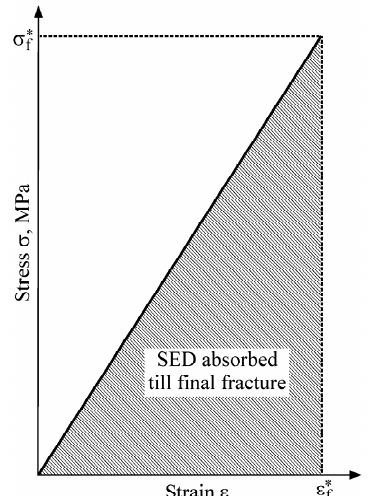
Figure 4. Schematic of the stress-strain curve for the equivalent brittle material. Reproduced with permission from Torabi, A.R.; Berto, F.; Campagono, Phys. Mesomech. Published by Springer, 2016 [28].